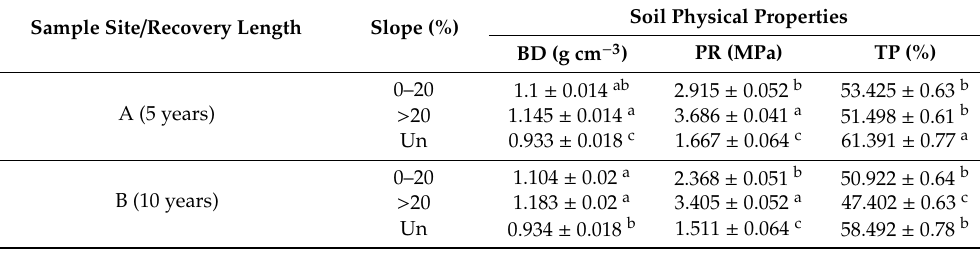
Table 6. Means ± standard deviation of di ff erent physical soil properties on skid trails in di ff erent treatments. BD: soil bulk density; PR: penetration resistance; TP: total porosity. A, B, C, D, and Un represent, respectively, skid trails after a period of 5 years, 10 years, 15 years, 20 years and Undisturbed